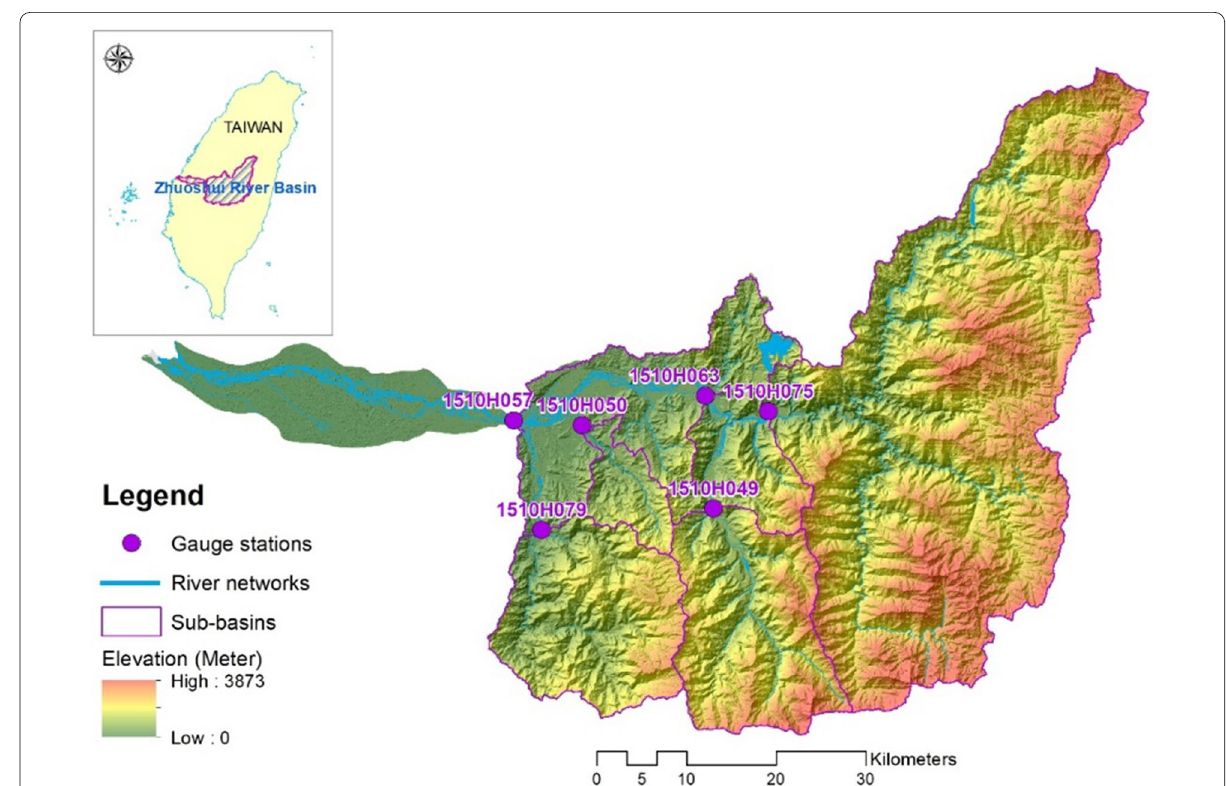
Fig. 1 Geographic location of the Zhuoshui River Basin; its sub‑basins; and pink dots along with texts are gauge stations and code